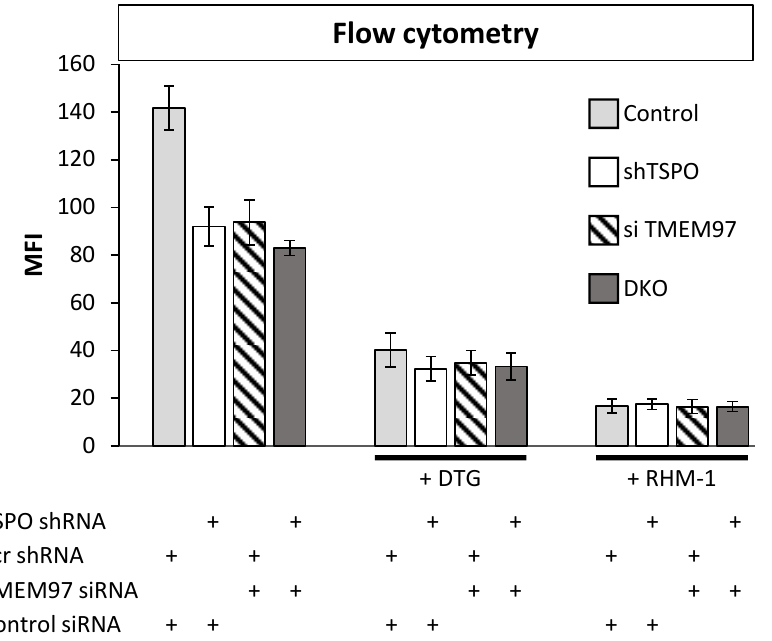
Figure 2. Double knockout (DKO) of TMEM97 and TSPO produced no further reduced SW120 signal in MP cells. The figure shows the first incubating condition for four differently treated cell lines. That includes Scr control cell lines, cells with an attenuated level of TSPO or TMEM97, and cells with the attenuated level of both TSPO and TMEM97 (DKO). Those cells were incubated with SW120 for 30 min at 37 ◦ C. All treatments were significantly different from control cells (ANOVA, post hoc Tukey’s HSD, p < 1 × 10 − 7 ). The right bars show the same condition, but with the treatment of DTG or RHM-1 prior to incubation with SW120. Cells were incubated with complete media supplemented with 10 nM DTG or 4 nM of RHM-1 for 1 h at 37 ◦ C. For DTG-treated cells (+DTG), the DTG-treated control cells were significantly different at the p < 0.0001 level from the untreated control cells. All DTG-treatment conditions (shTSPO, si TMEM97, and DKO) were significantly different from DTG-treated control at the p < 0.005 level ( t -test on + DTG cells only). All RHM1-treated cells (+ RHM-1) were significantly different from respective untreated cells at the p < 0.001 level ( t -test on + RHM-1 cells only). There was no significant difference between Control, shTSPO, siTMEM97, or DKO for RHM-1 and DTG-treated cells ( t -test on + DTG or + RHM-1 treated